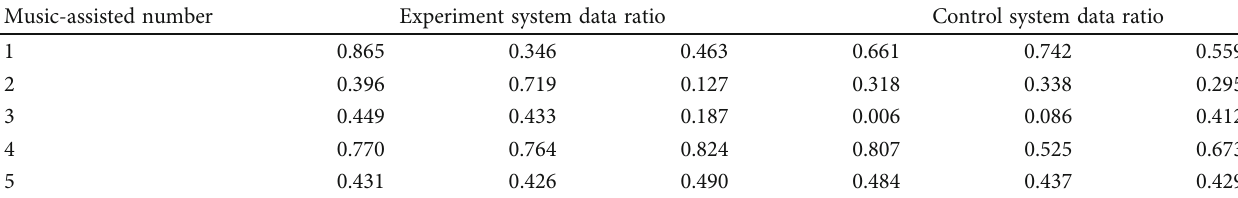
Table 1: Attributes of music-assisted interactive